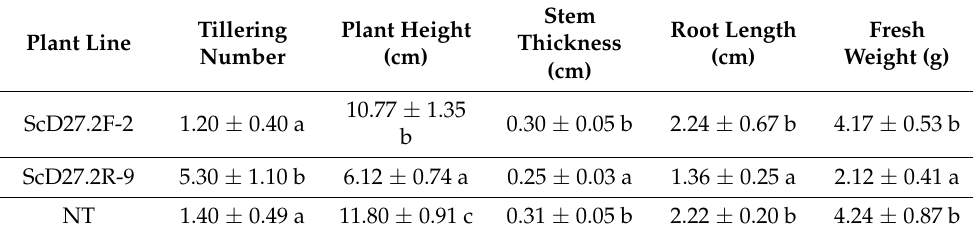
Figure 10. Phenotypes of ScD27.2F-2 and ScD27.2R-9 transgenic and NT non-transgenic lines sub- jected to drought stress. F-2, R-9, and NT are F-2 and R-9 drought-stressed lines and normal lines. Scale bar = 1 cm. Table 3. Effects of drought stress on the phenotypes of ScD27.2F-2 and ScD27.2R-9 transgenic and NT non-transgenic lines.